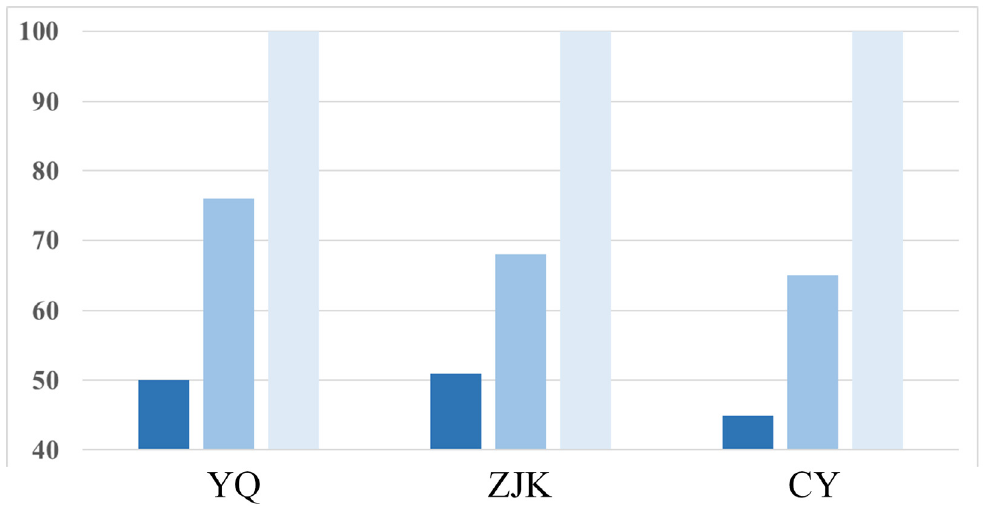
Figure 3. Probabilities (unit: %) of occurrences for ECS type (dark blue), CS type (blue) and all temperature drop types (light blue) at each station in case of a temperature decrease below the fifth percentile threshold in the domain. (YQ: Yanqing, ZJK: Zhangjiakou, CY: Chaoyang).